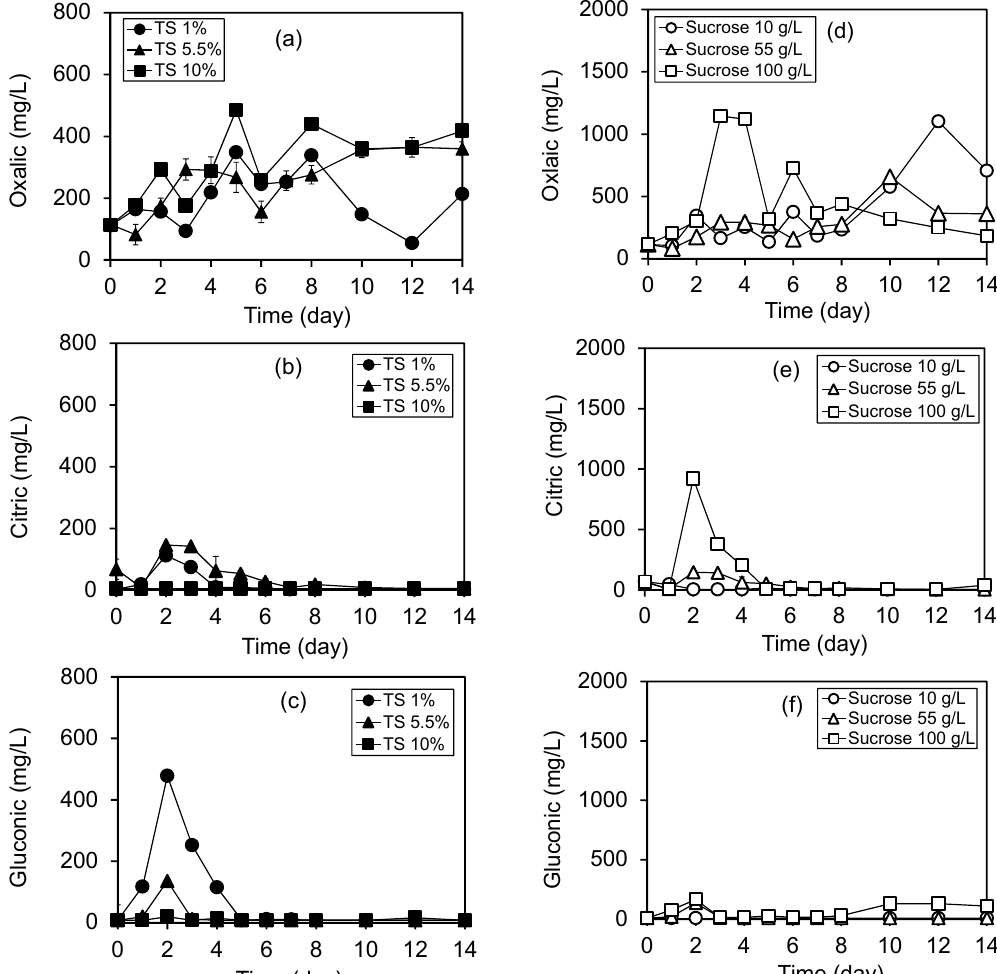
Figure 2. Production of organic acids during the fungal bioleaching experiments ( a – c ) effects of sludge solid content, ( d – f ) effects of sucrose concentration.